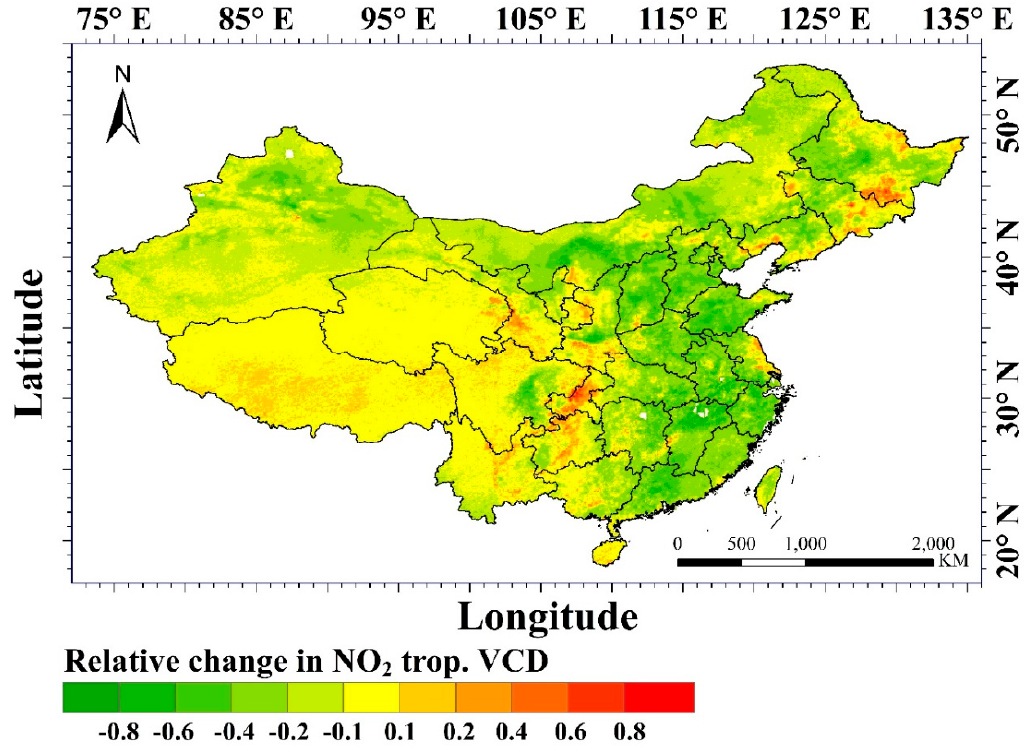
Figure 3. Estimated effect of the virus containment measures on the TNO2_ave concentrations over China: green colors indicate a reduction, red colors indicate enhancement; light colors (yellow) indicate no or little effect (see color scale for values).